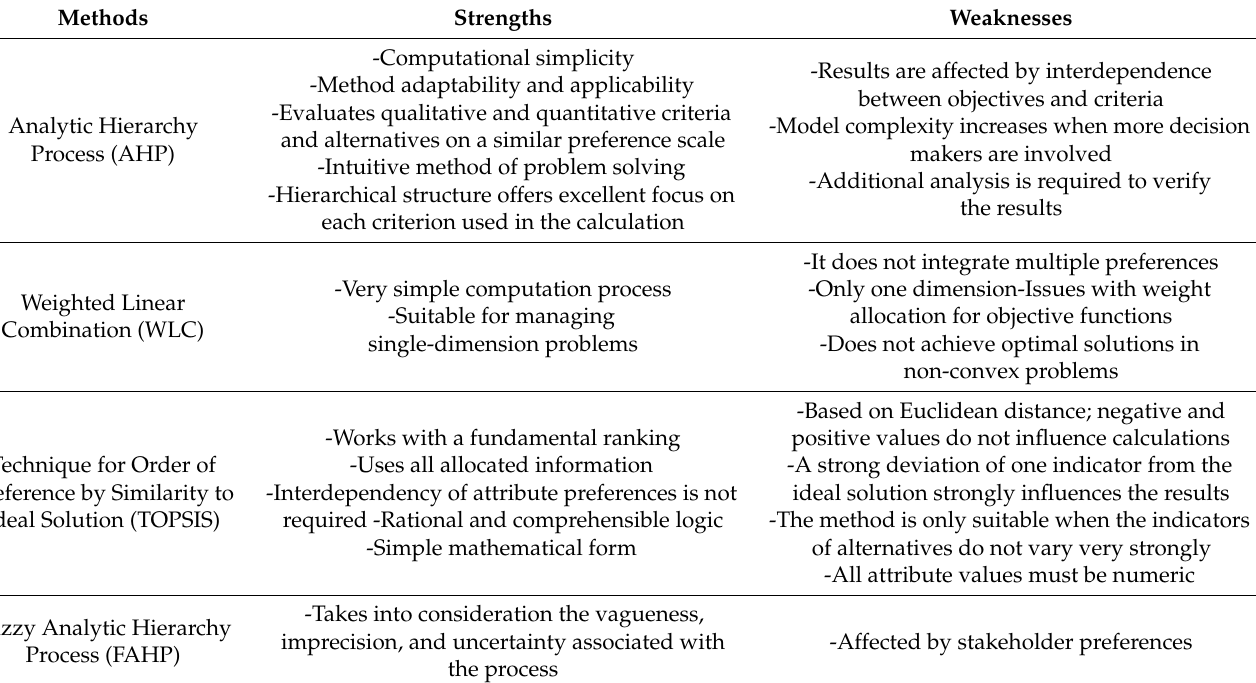
Table 2. Comparison between multi-criteria decision analysis (MCDA) methods